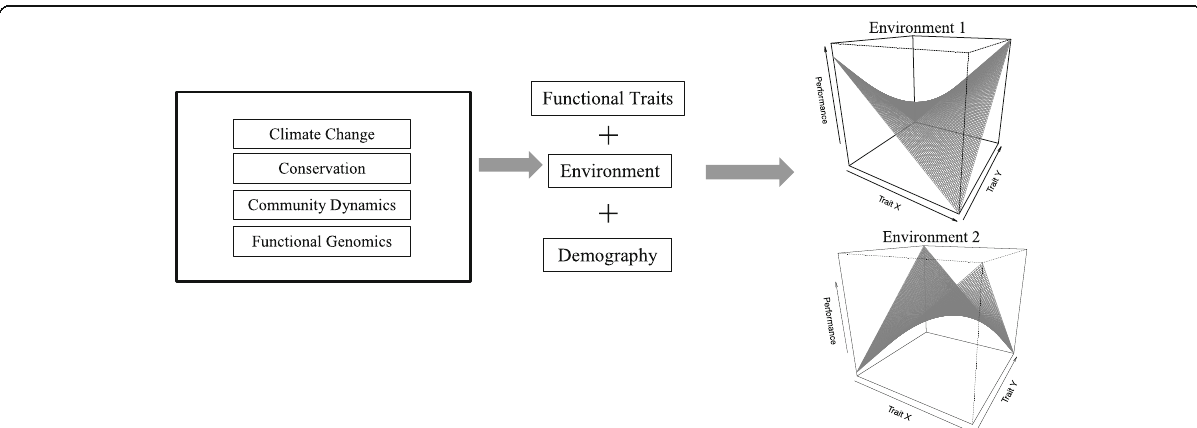
Fig. 2 Major areas of tropical tree ecology are studied by linking functional traits, demography, and the environment. All three of these contexts and their interactions must be considered in analyses to adequately explain differential performance across environments, identify the axes of function that clearly predict this performance, and explain the vast diversity of form and function of trees seen in the tropics. We argue that the greatest advances in trait-based studies of tropical forests in the future will come through an explicit consideration of how organismal-level function interacts with abiotic and biotic contexts to drive differential tree demography and ultimately forest dynamics. Without an explicit consideration of these contexts and richer assays of tree function via anatomical and physiological traits and functional genes, little additional progress may be